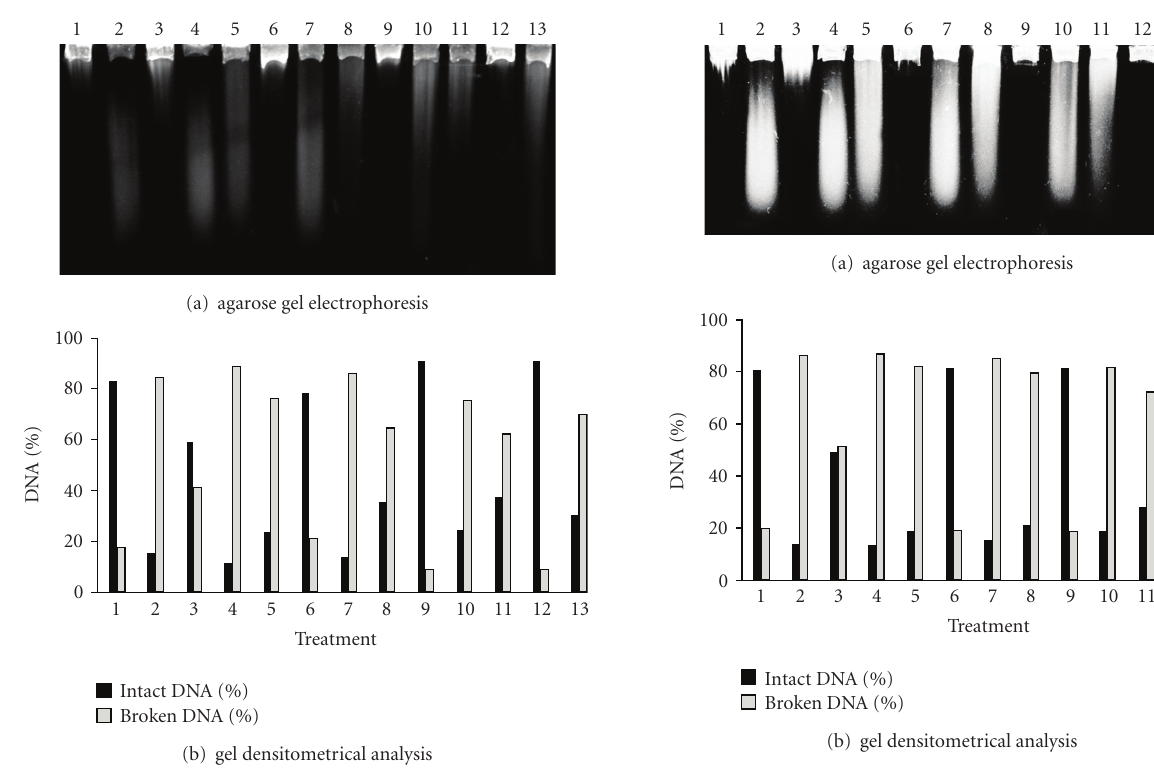
Figure 8: Alkaline gel electrophoresis of E. coli BW527 treated with SnCl 2 (25 μ g/mL), UVA (90kJ/m 2 ) and pre-illuminated with UVA, followed by SnCl 2 incubation. Lanes: (1) control; (2) SnCl 2 ; (3) UVA; (4) UVA + SnCl 2 ; (5) SnCl 2 30 minutes; (6) UVA 30 minutes; (7) UVA + SnCl 2 30 minutes; (8) SnCl 2 60 minutes; (9) UVA 60 minutes; (10) UVA + SnCl 2 60 minutes; (11) SnCl 2 90 minutes;